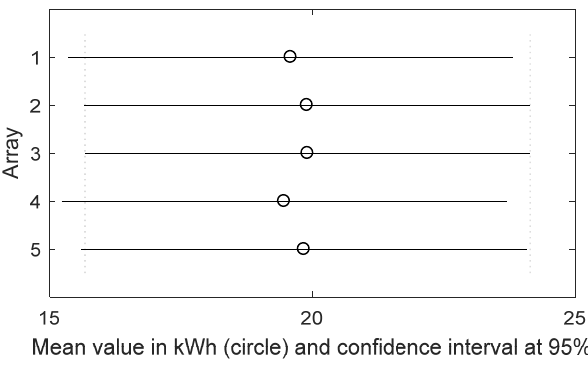
Figure 4. Box plot of ANOVA test of the five distributions for the one-month analysis (January).